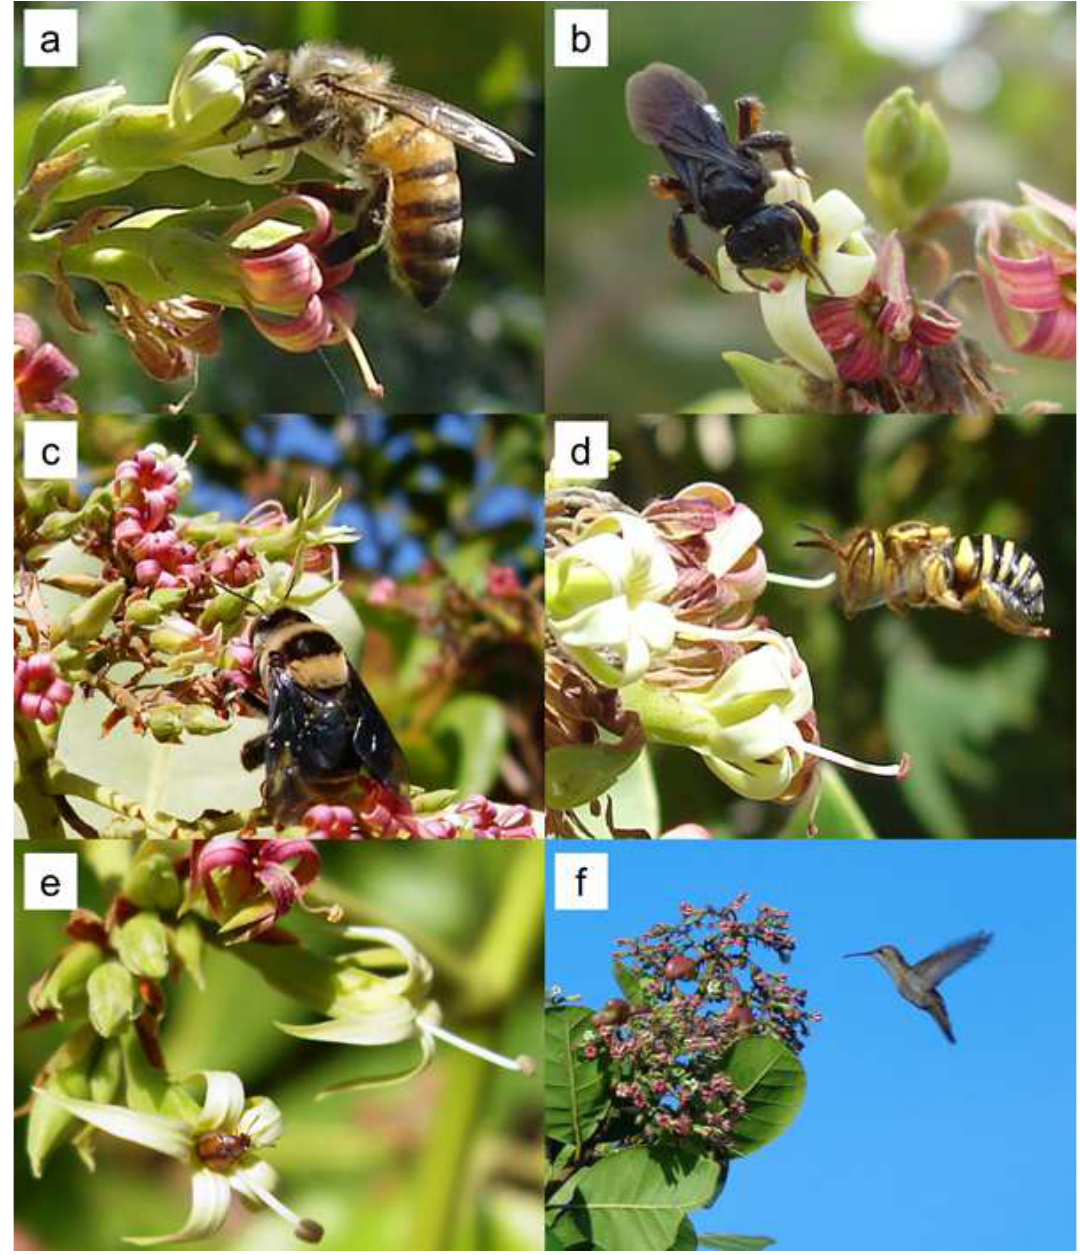
F IGURE 2. Plate showing some of the floral visitors recorded in cashew flowers: a visitors (b - the stingless bee Trigona spinipes ; c